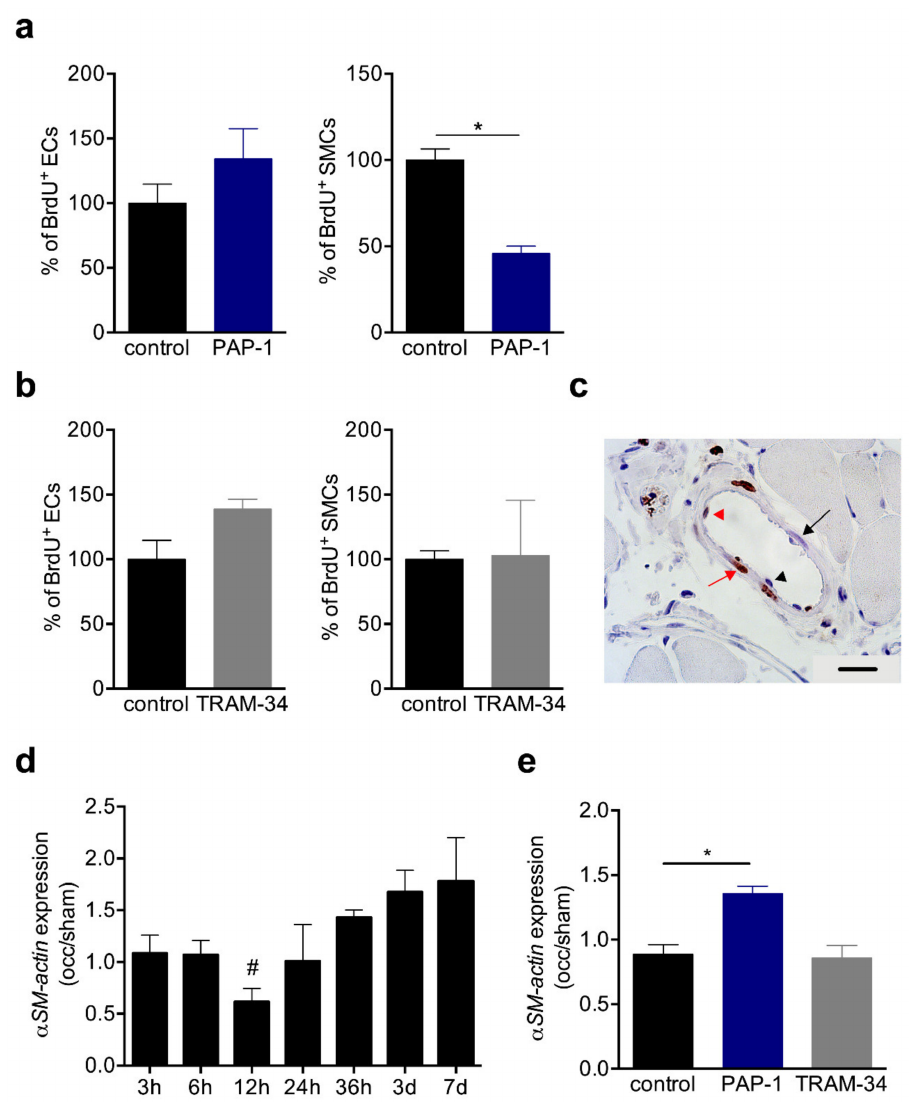
Figure 5. BrdU incorporation and α SM-actin expression in collaterals. ( a , b ) Bar graphs represent the results of quantitative analyses of BrdU + ECs (left panels) and SMCs (right panels) in solvent (control), ( a ) PAP-1 or ( b ) TRAM-34-treated mice at day 7 after induction of arteriogenesis. Data are means ± SEM, n = 3 mice per group. * p < 0.05 from unpaired student´s t-test. The numbers of BrdU + cells in control collaterals were defined as 100%; ( c ) Representative picture of a BrdU stained collateral at day 7 after induction of arteriogenesis. Scale bar 20 µ m; ( d , e ) The bar graphs represent the expression levels of α SM-actin (occlusion / sham (occ / sham)) in collateral arteries ( d ) at di ff erent time points after induction of arteriogenesis or ( e ) at 12 h after induction of arteriogenesis in control, PAP-1, or TRAM-34 treated mice. The qRT-PCR results were normalized to the expression level of the 18SrRNA. Data are means ± SEM, n > 3 per group. * p < 0.05 from unpaired student’s t-test and refers in ( d ) to occ vs.